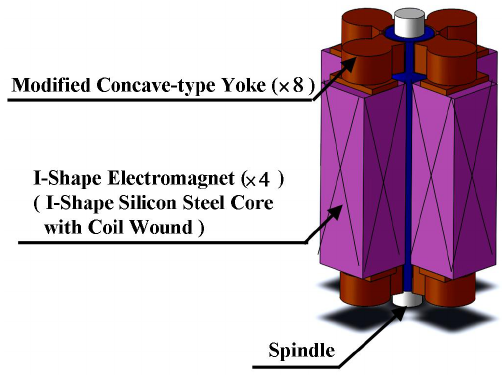
Figure 2. Configuration of the embedded cylindrical-array magnetic actuator (ECAMA).